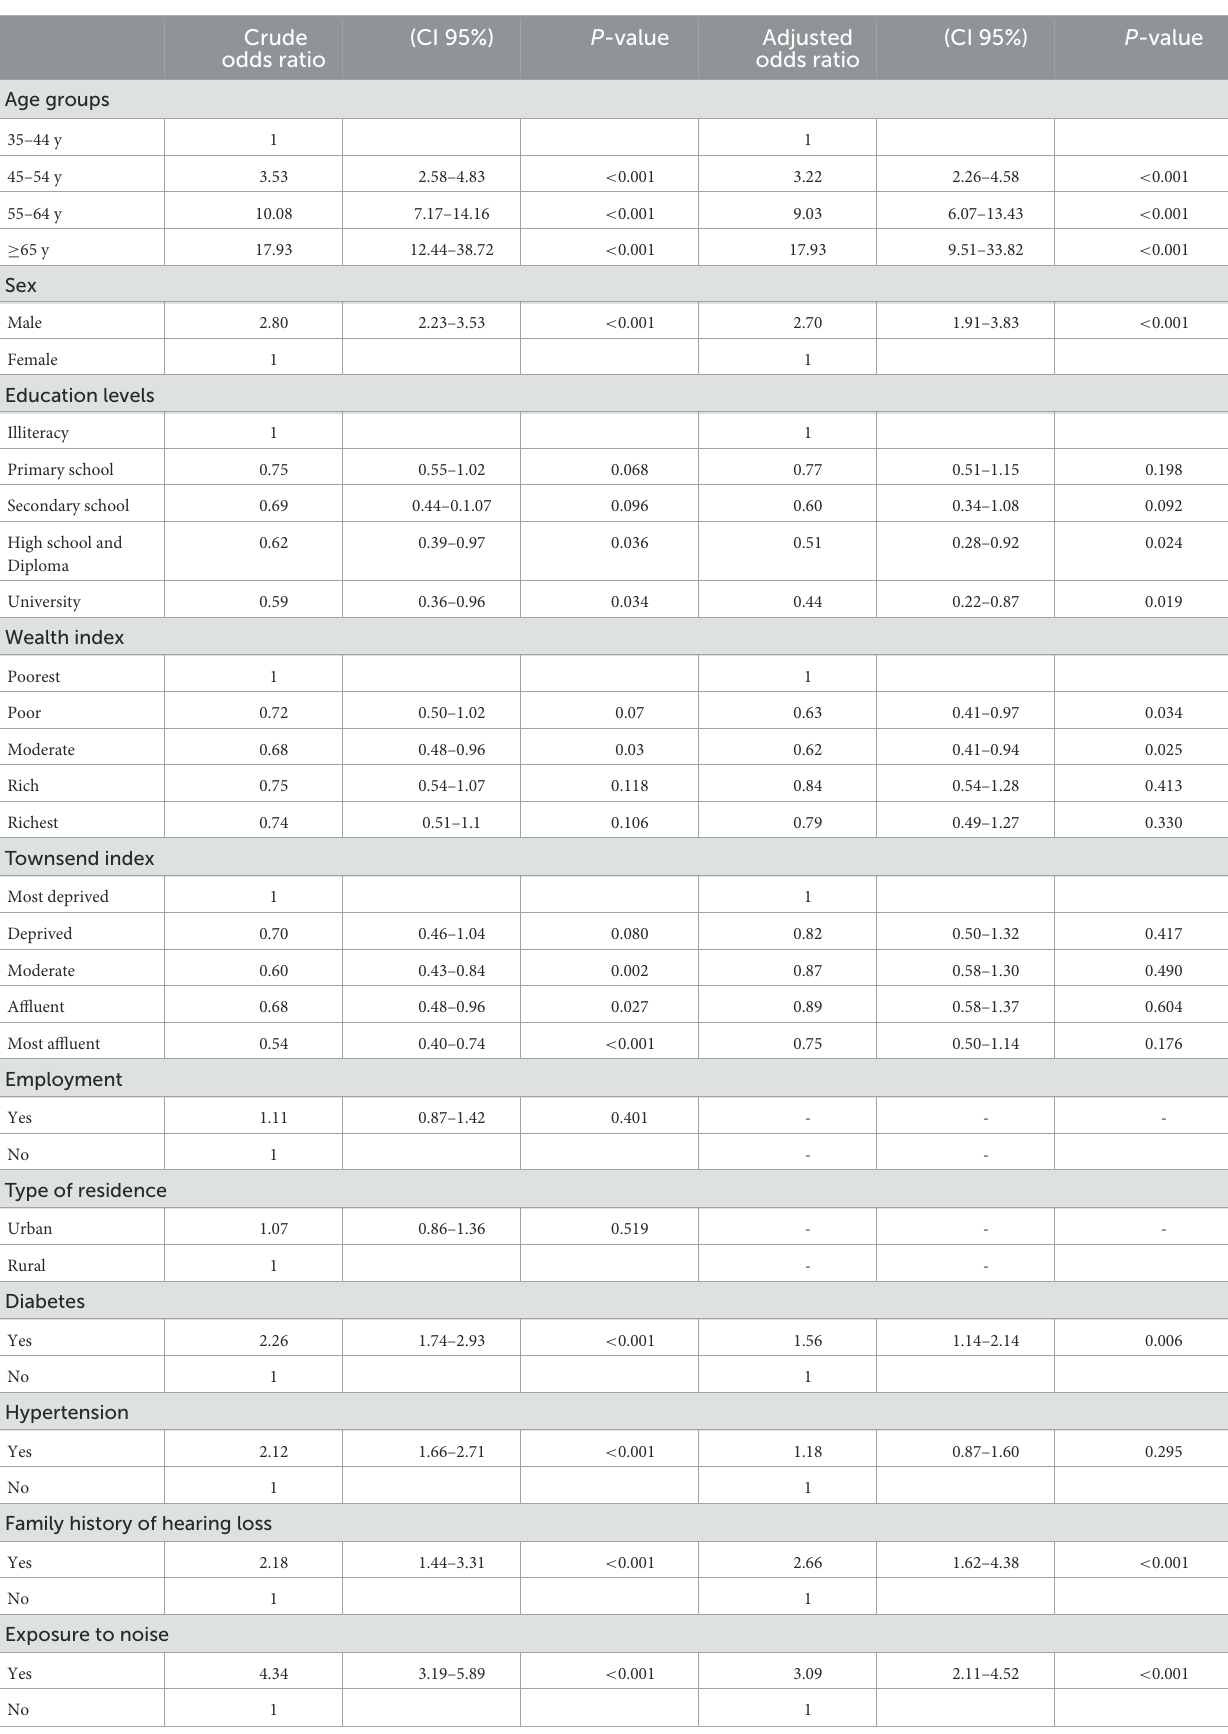
TABLE 2 Crude and adjusted odds ratios of hearing loss using the logistic regression model. Crude (CI 95%) P -value Adjusted odds ratio